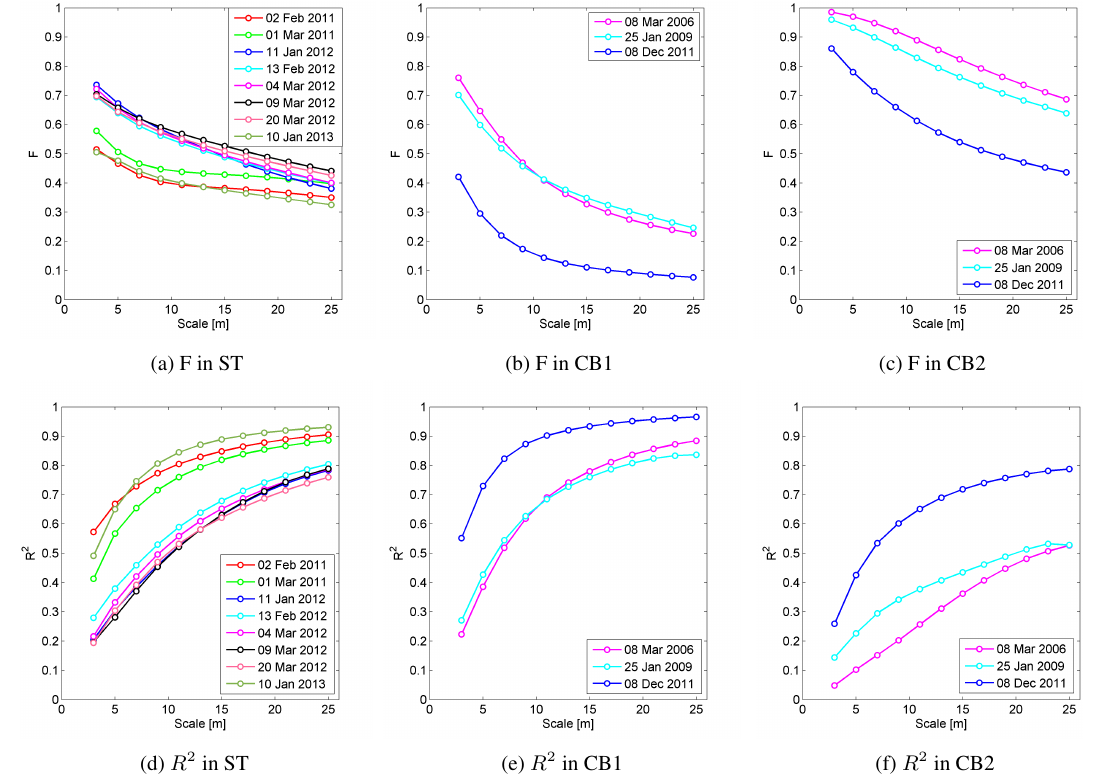
19 Fig. 7: Snow surface roughness as a function of terrain roughness for every pixel in CB1 in the year 2011 for scales of (a) 5 m and (b) 25 m. In green the linear regression line.